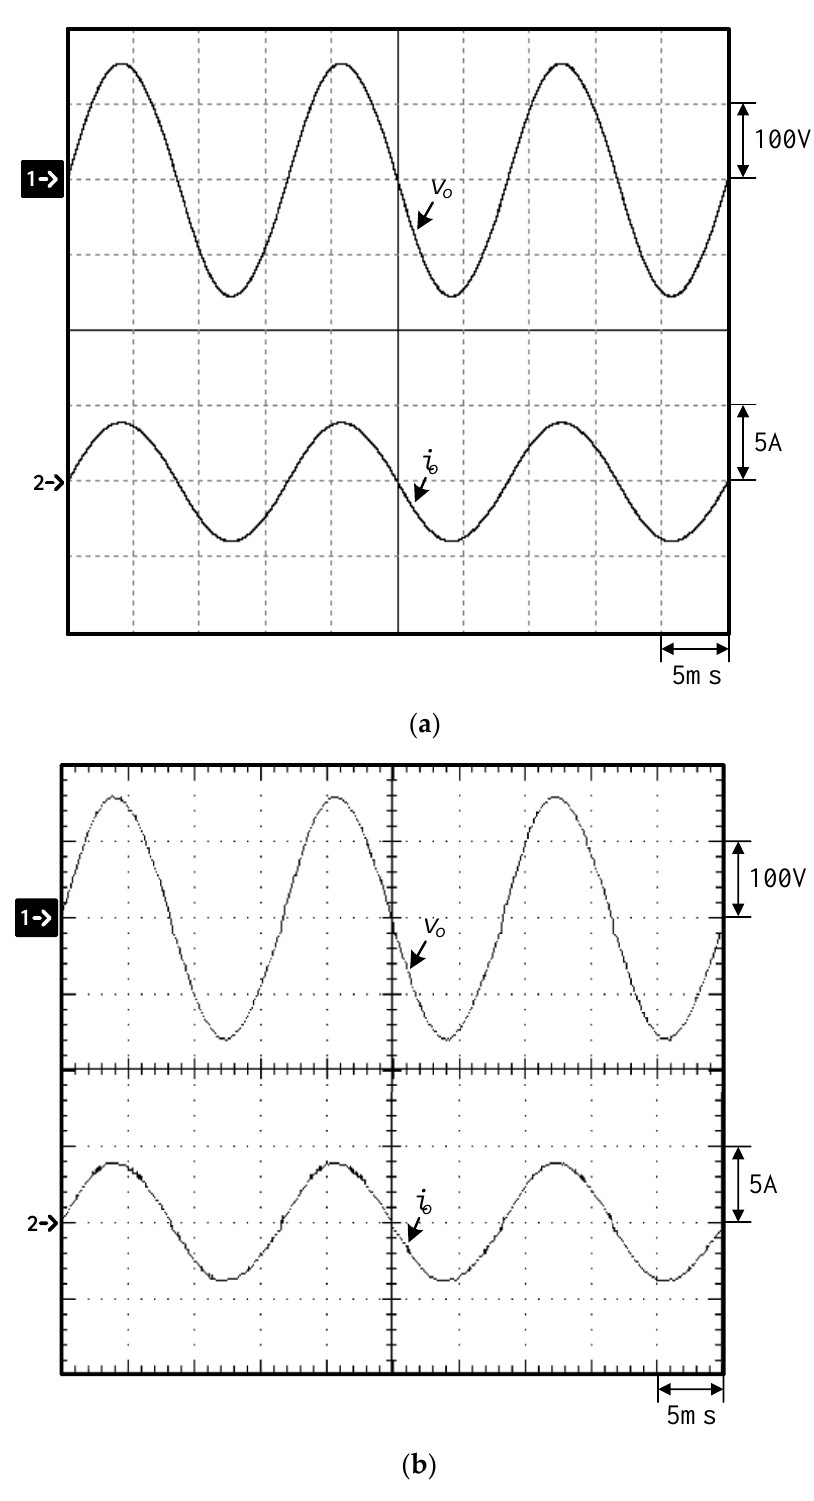
Figure 15. Waveforms at rated load with (1) v o and (2) i o : ( a ) simulated; ( b ) measured.